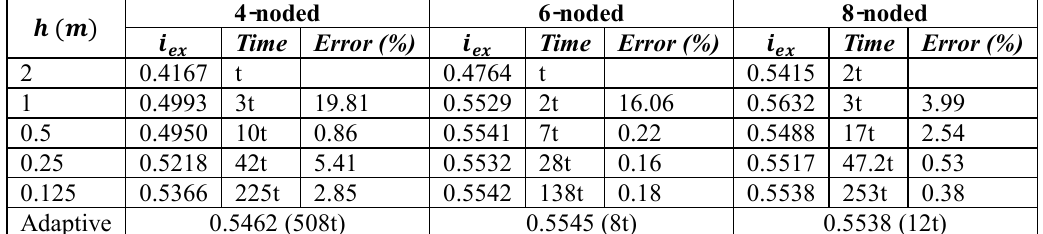
Results of convergence study for weir with